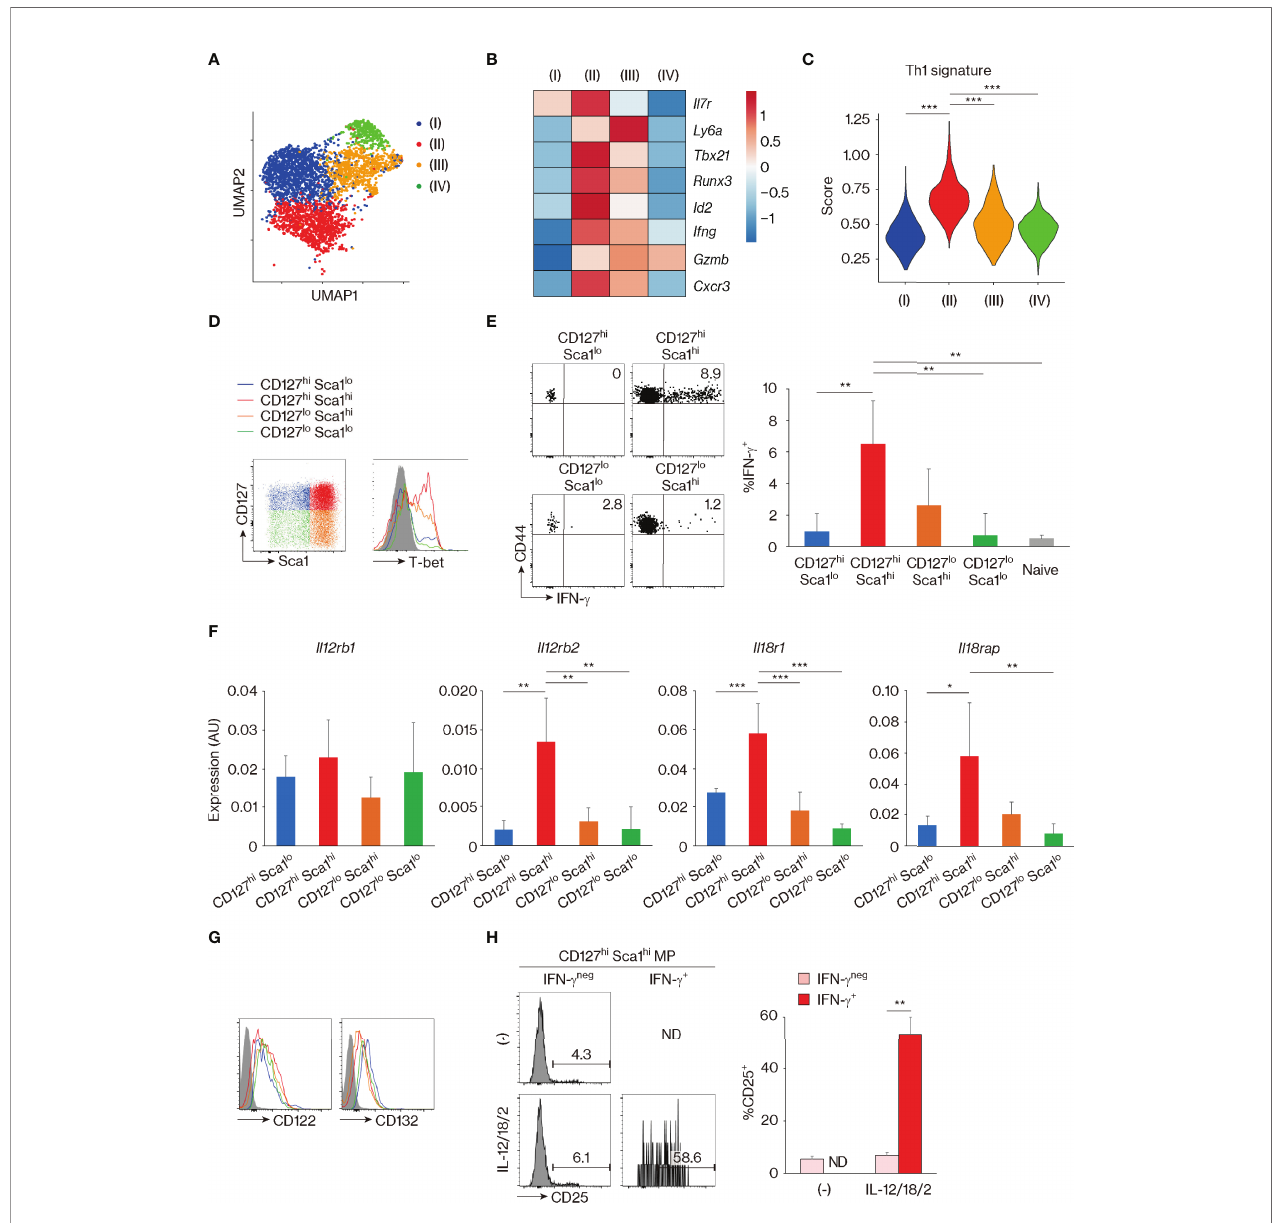
FIGURE 5 | CD127 hi Sca1 hi memory-phenotype (MP) T lymphocytes can exert innate Th1-like activity in vitro . (A – C) Clustering analysis of MP T lymphocyte population. Single-cell RNA sequencing (scRNAseq) data of MP cells in Figure 1C were analyzed by unsupervised clustering. (A) The plot displays single cells determined by the Uniform Manifold Approximation and Projection (UMAP) algorithm. Each dot represents a cell, and colors highlight unsupervised cell clusters. Clusters representing less than 5% of the total MP population were excluded. (B) A heatmap showing row-standardized expression of selected genes among MP clusters. (C) A violin plot depicting relative expression of Th1-associated genes in the indicated MP clusters. (D) CD127 hi Sca1 hi MP cells express the highest levels of T-bet. A representative histogram showing T-bet levels in each MP subset from 3 mice is depicted. (E) CD127 hi Sca1 hi MP subpopulation can produce IFN- g in response to Th1-differentiating cytokines in the absence of antigen (Ag) recognition. Sorted MP as well as naïve CD4 + T cell subpopulations were stimulated with IL- 12, IL-18, and IL-2 for 24 h. The dot plots show IFN- g production by the indicated cells, while the bar graph depicts the IFN- g + fraction (mean ± SD) among the MP and naïve subpopulations (n = 4 mice). Data shown are representative of 2 independent experiments performed. (F) The CD127 hi Sca1 hi MP subset expresses high amounts of Il12rb2 , Il18r1 , and Il18rap . Bar graphs showing relative expression levels of the indicated genes in each MP subpopulation are depicted (n = 4 mice). Data are representative of 2 independent experiments. (G, H) CD127 hi Sca1 hi MP cells express functional IL-2 receptors under the presence of Th1-differentiating cytokines. Representative histograms in (G) display CD122 and CD132 expression in each MP subset from 4 mice in steady state, while those in (H) show CD25 expression in IFN- g neg and IFN- g + fractions of sorted CD127 hi Sca1 hi MP cells that were cultured in the presence or absence of IL-12, IL-18, and IL-2 for 24 h. A bar graph indicating the frequency (mean ± SD) of CD25 + cells among each group is also depicted (n = 3 mice). Data are representative of 2 independent experiments performed. Statistically signi fi cant differences are indicated as * p < 0.05, ** p < 0.01, and *** p < 0.001. ND, not